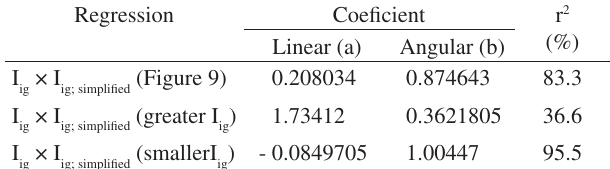
× I . ig ig; simplified